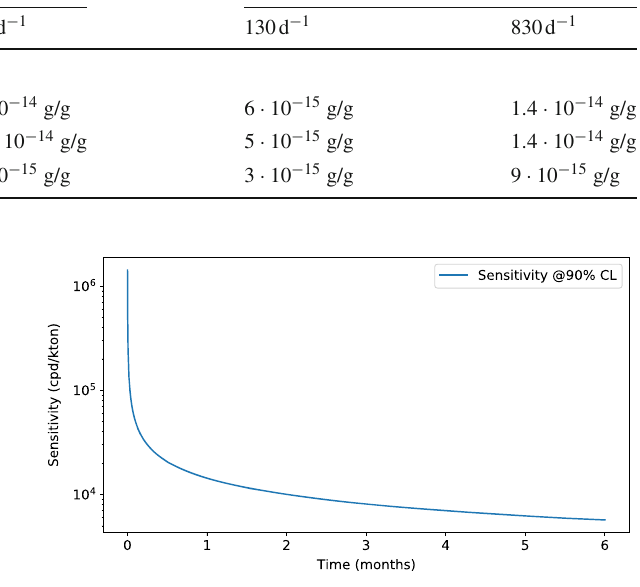
Fig. 20 The 90% CL sensitivity of OSIRIS to a contamination by 85 Kr in dependence of the measurement time. The maximum time of 6 months shown in this plot is the total duration of the JUNO detector filling with the